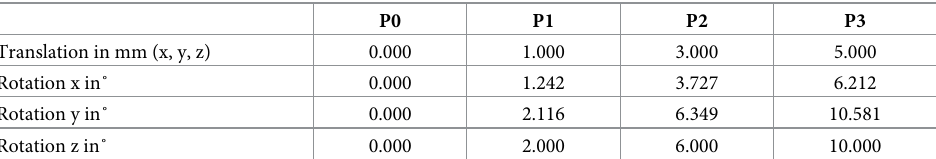
Table 3. Translational and rotational positions using the manual reference